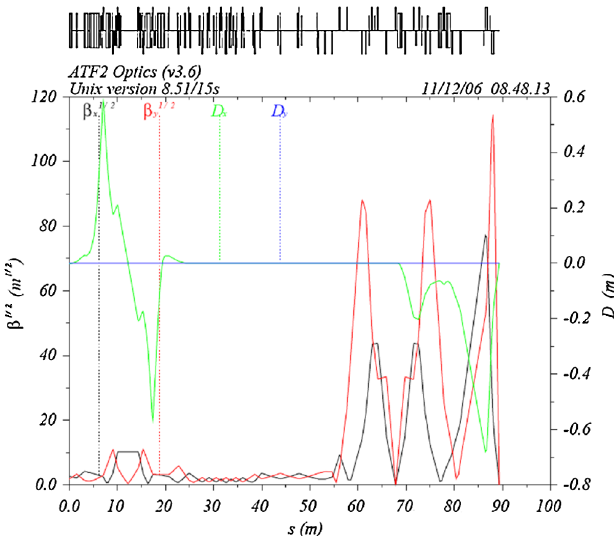
FIG. 2. (Color) ATF2 optics from the ATF damping ring extrac- tion point on the left to the IP on the right. The extraction line extends over the first 25 meters, followed by the diagnostic and matching section in the next 30 meters. The final focus section stretches over the last 35